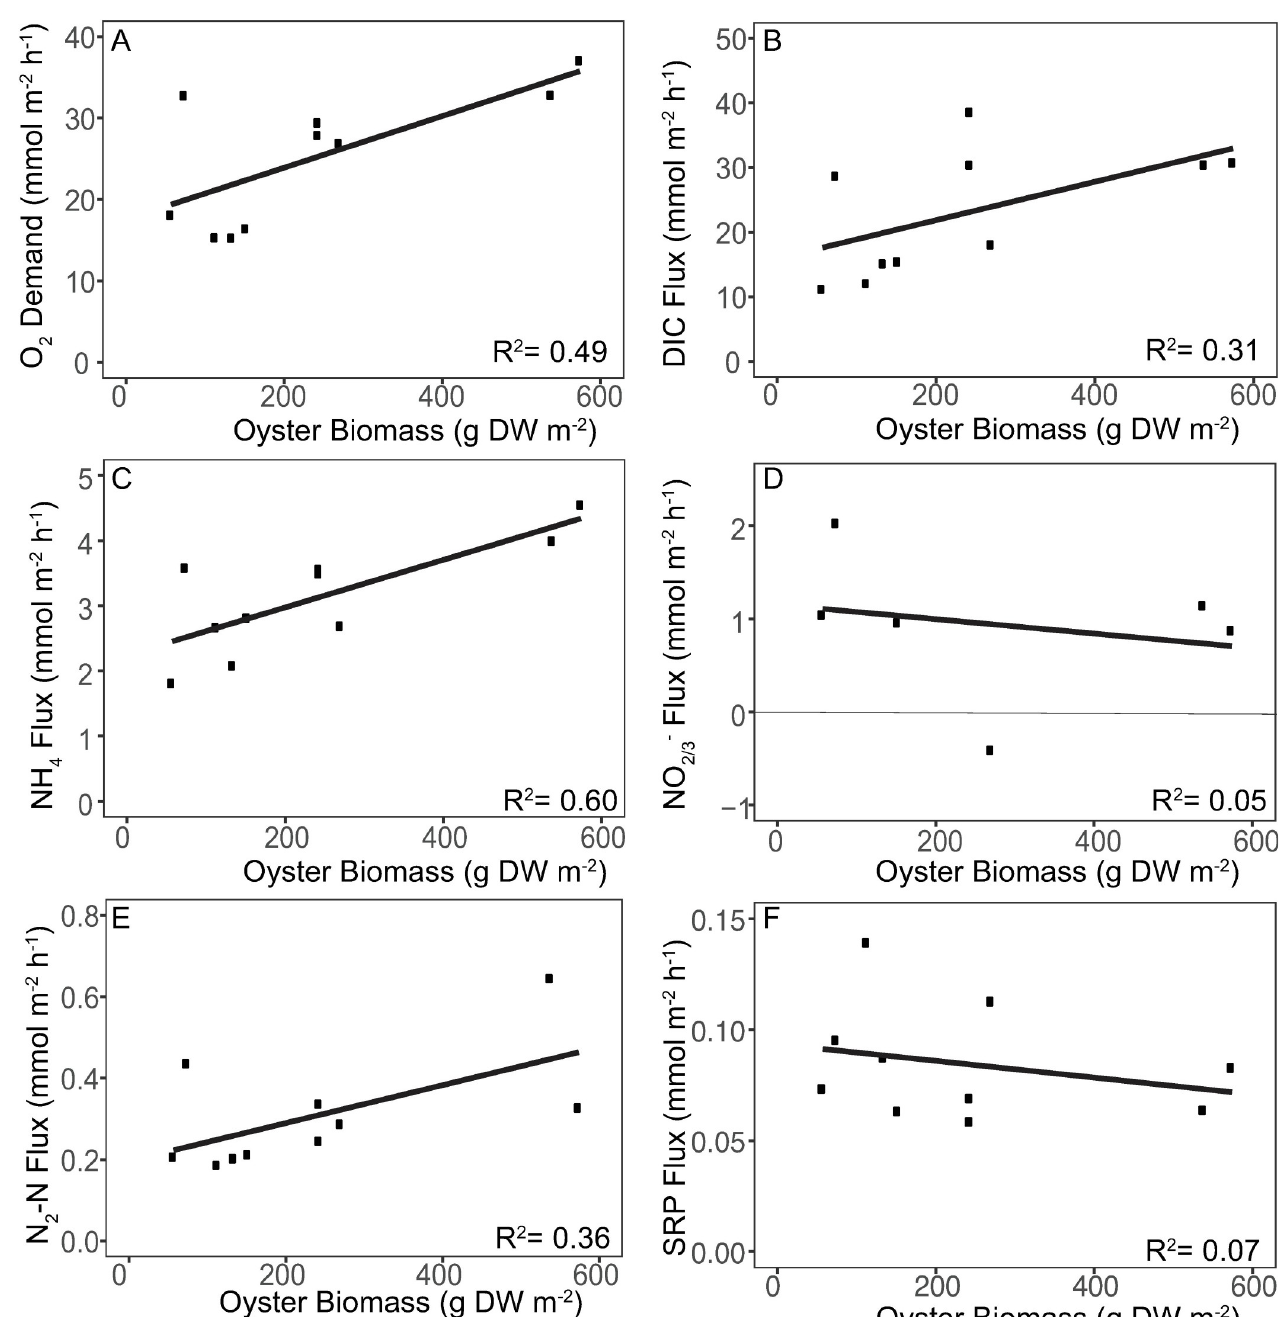
Fig 4. Regressions of fluxes from oyster clumps against oyster biomass. Regressions of (a) oxygen demand (b) DIC (c) NH 4+ (d) NO 2/3- (e) N 2 (f) and SRP fluxes.